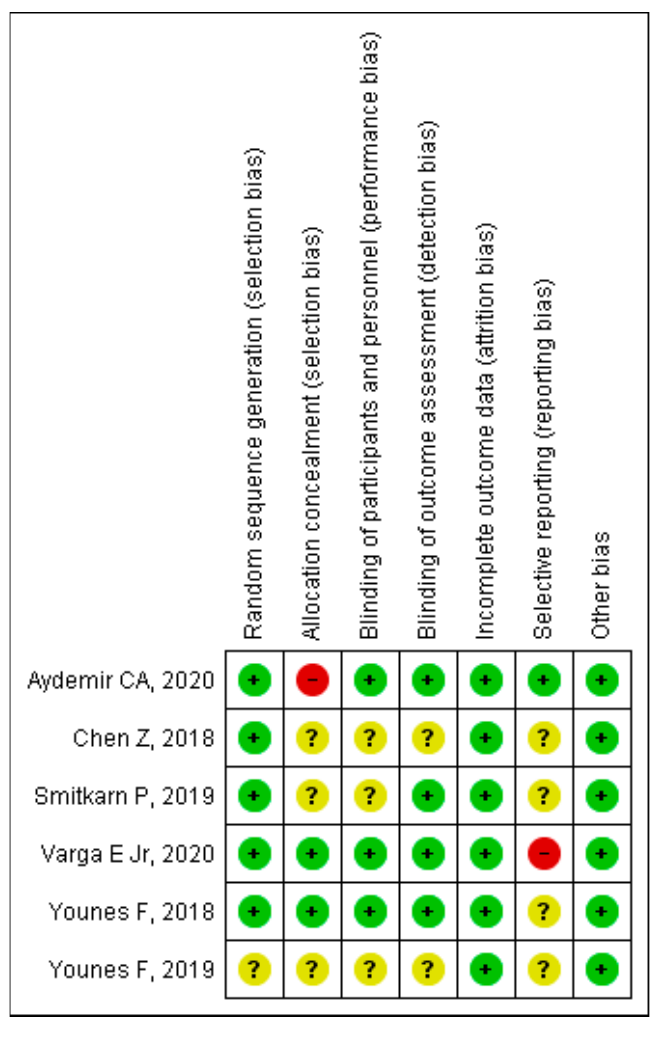
Figure 3. Risk of bias summary [19–24].